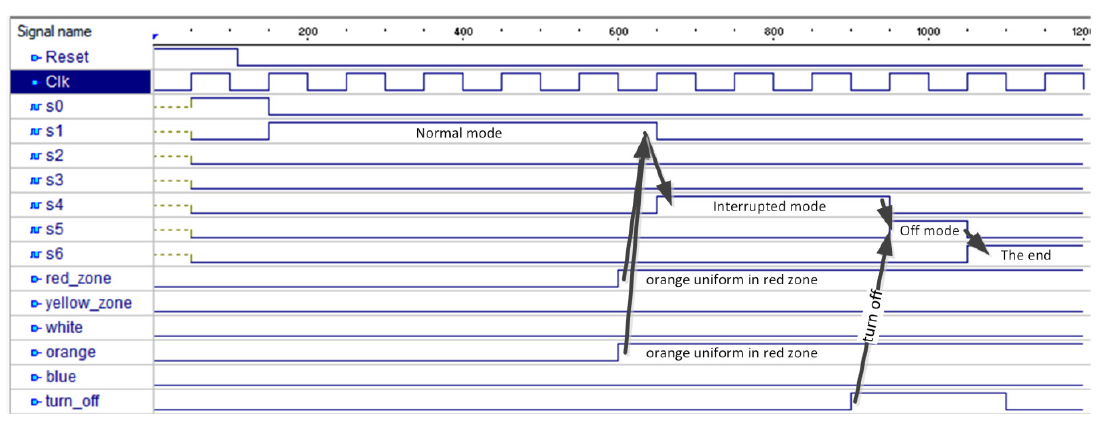
Figure 11. Simulation results of the case study.